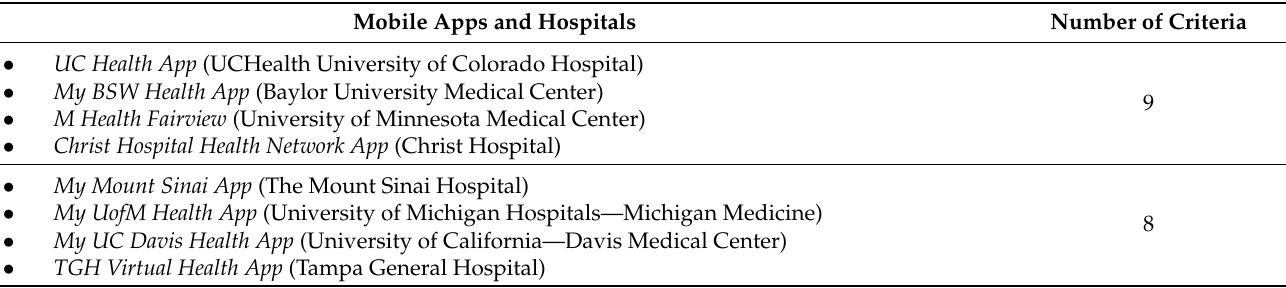
Table 4. Best apps by number of